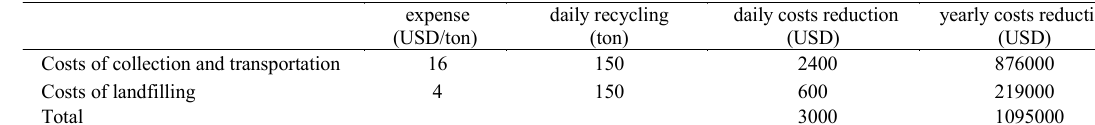
Table 4: Revenues of recycling through diversion from landfilling